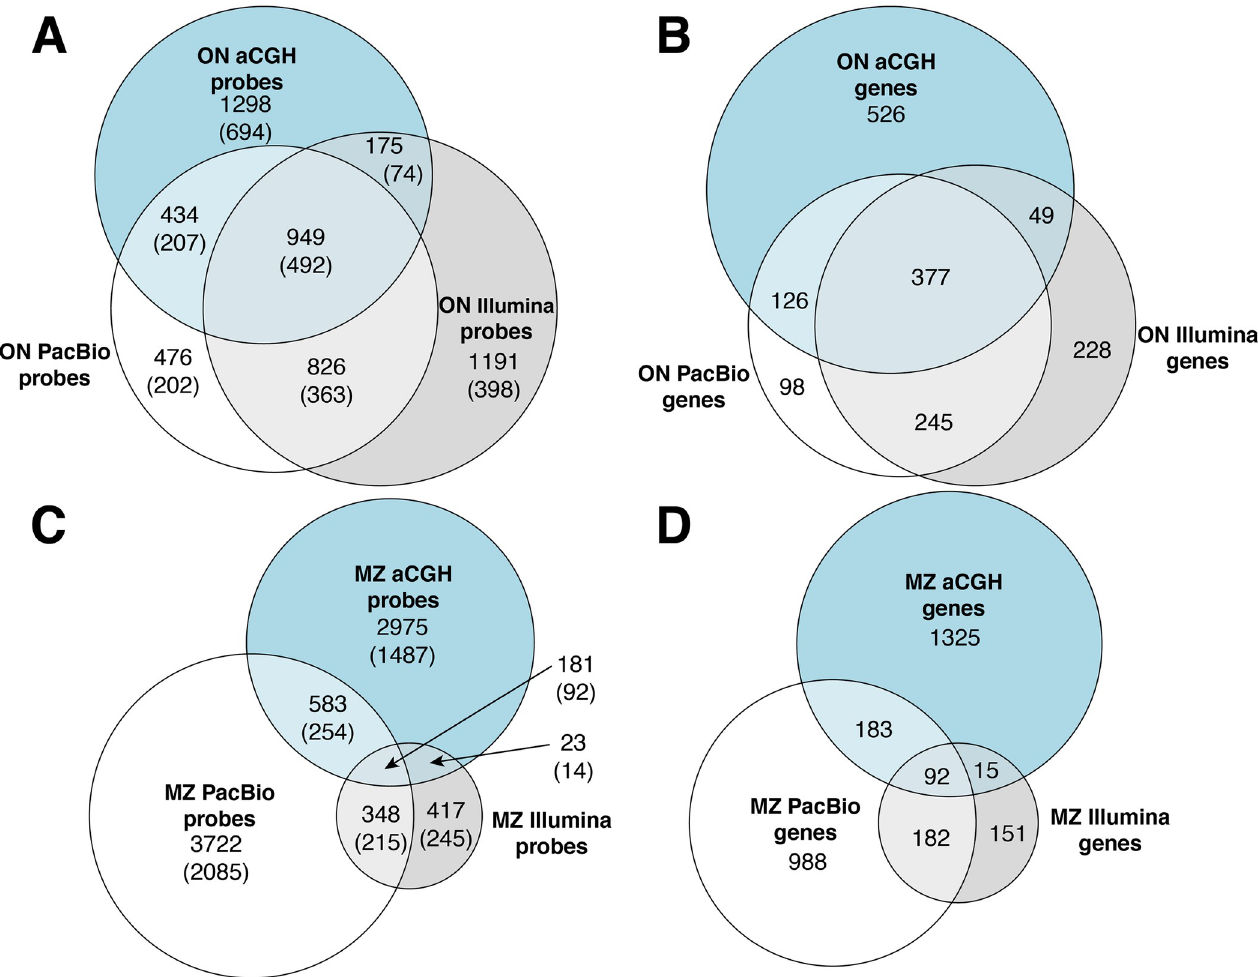
Fig 3. Euler Diagram showing counts of probes and genes detected as copy number variable for each technology. (A) and (B) are counts of probes and the genes they represent, respectively, that appear to have O . niloticus bias by at least one of the three platforms, while (C) and (D) are counts of probes and genes, respectively, that appear to have M . zebra bias by at least one platform. Probe counts listed in (A) and (C) include both intergenic and genic probes while counts in parentheses include genic probes only. For a probe to be biased towards a species in NGS assemblies, there must be more exact sequence matches in one assembly than the other. To account for noise in aCGH results, probes must be species biased after filtering of near-neutral log 2 hybridization ratios (+/-0.8).